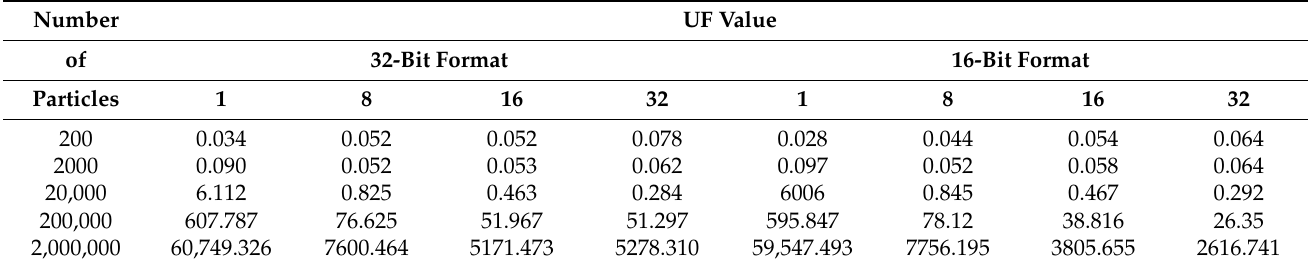
Table 2. Kernel time in seconds for the different executions. UF: unroll